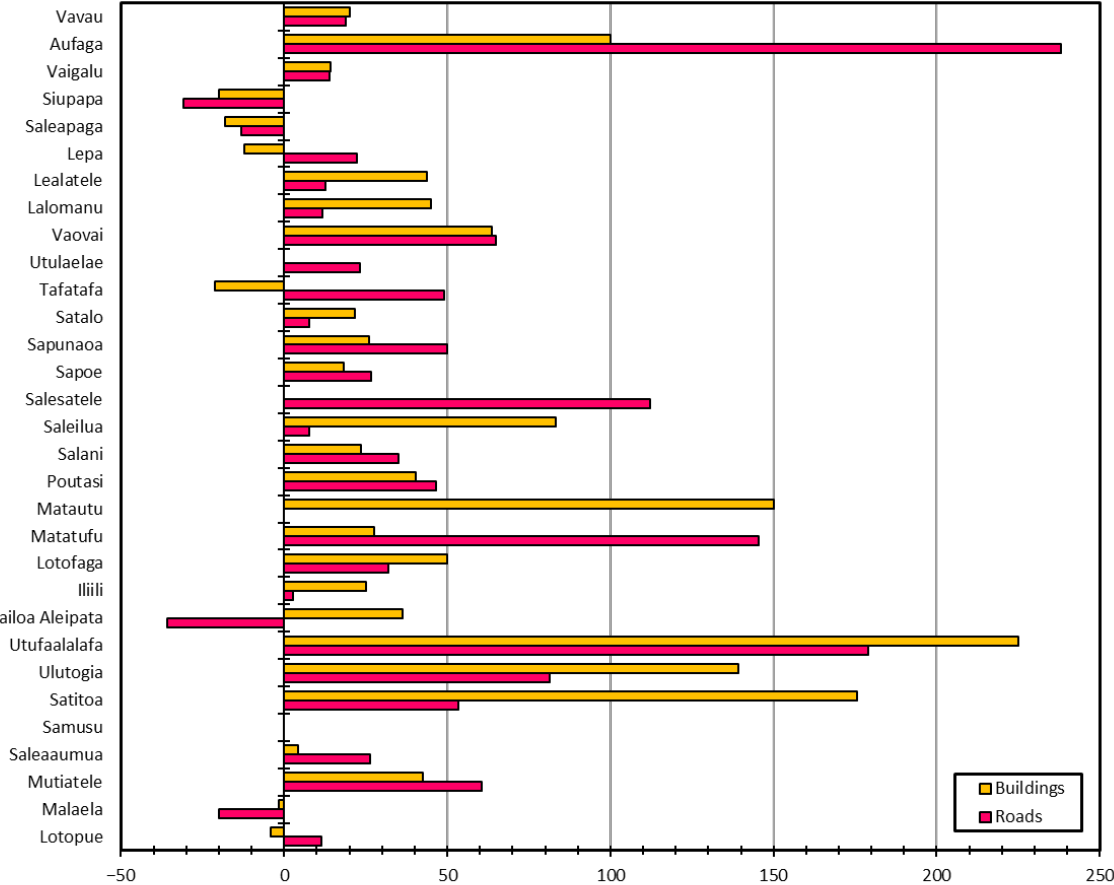
Figure 7. Percentage difference of the 50 m exposure model distributions for buildings and roads relative to the 10 m results for villages in southeast Upolu. A positive difference suggests overestimation whereas a negative difference suggests underestimation of the 50 m resolution scenario compared to the 10 m resolution scenario.